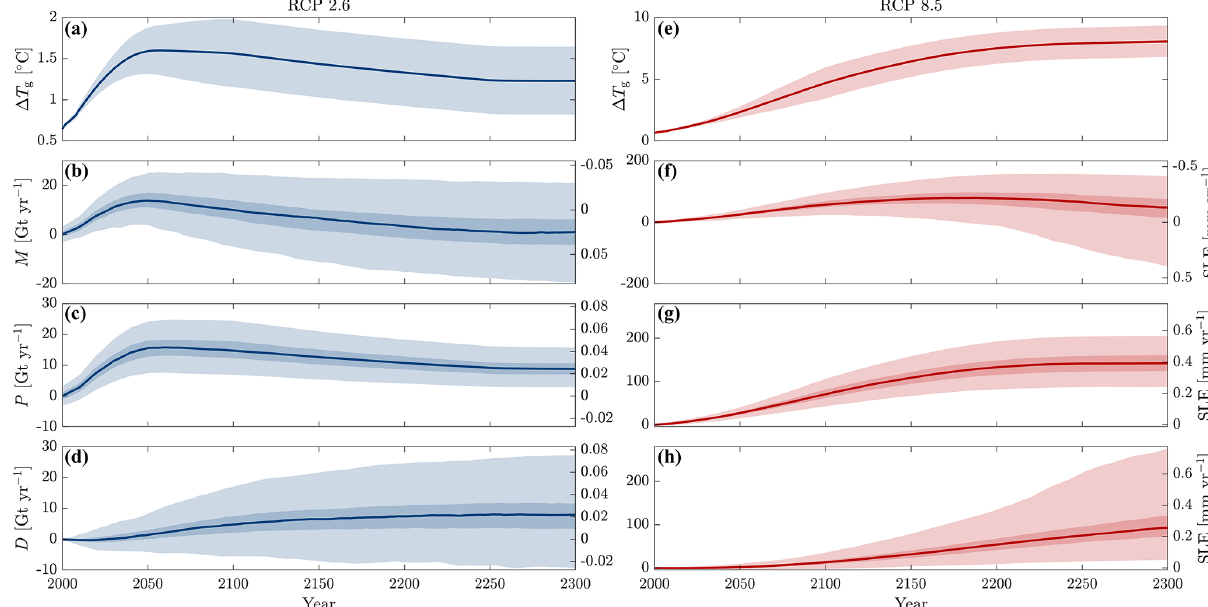
Figure 8. Projected temperature changes and mass balance changes for RCP2.6 ( a–d , blue lines) and RCP8.5 ( e–h , red) between 2000 and 2300 from our training ensemble. Uncertainties are shown between 5% and 95% in light shading and between 33% and 66% in dark shading. (a, e) Global temperature anomalies. (b, f) Change in the rate of total mass change ( M ) in Gtyr − 1 calculated as P − D . (c, g) Change in the rate of accumulation ( P ) with respect to our control runs ( P rcp − P ctrl ), integrated over the grounded area in Gtyr − 1. (d, h) Change in the rate of ice discharge ( D ) calculated with respect to our control runs ( D rcp − D ctrl ), integrated across the grounding line in Gtyr − 1